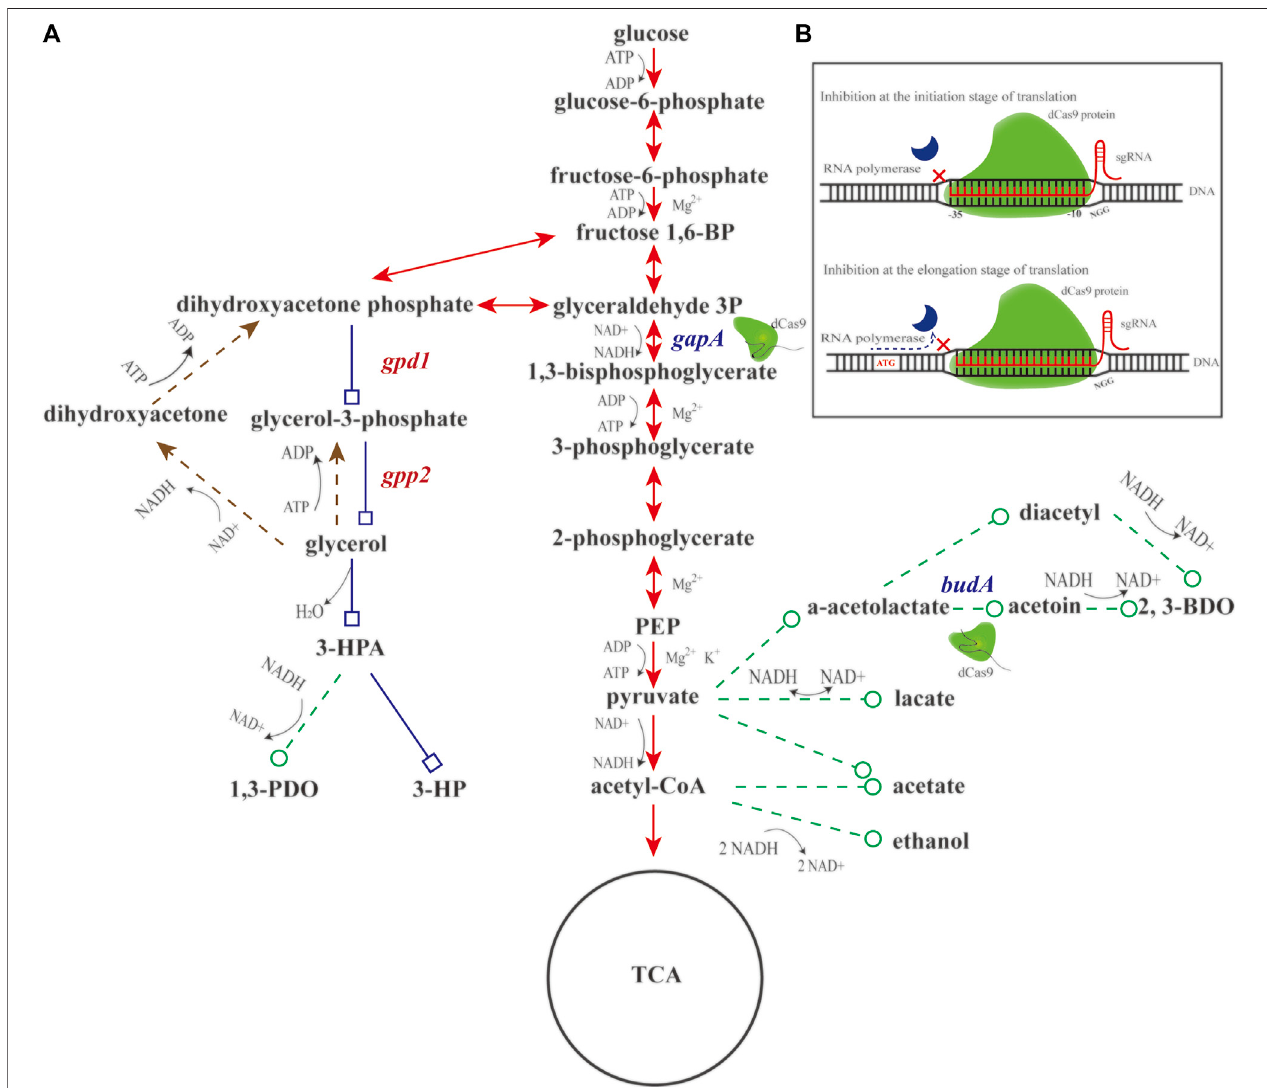
FIGURE 1 | Schematic diagram of engineering glucose-to-glycerol pathway and CRISPRi system in K. pneumoniae . (A) Diagram of engineering glucose-to- glycerol pathway. (B) Diagram of the CRISPRi system. Triangular arrow of solid line denotes the EMP pathway. Triangular arrow of dotted line denotes the glycerol oxidation pathway. Square arrow of solid line denotes the engineered glucose to 3-hydroxypropionic acid (3-HP) pathway, and circular arrow of dotted line denotes by- product pathways. gapA and budA are two native genes inhibited by CRISPRi. gpd1 and gpp2 are two heterologous genes introduced for glycerol production. Fructose 1,6-BP, fructose 1,6-diphosphate; glyceraldehyde 3P, glyceraldehyde-3-phosphate; PEP, phosphoenolpyruvate; 3-HPA, 3-hydroxypropionaldehyde; 3-HP, 3-hydroxypropionic acid; 1,3-PDO, 1,3-propanediol; 2,3-BDO, 2,3-butanediol; gpd1 , glycerol 3-phosphate dehydrogenase; gpp2 , glycerol 3-phosphatase; gapA , glyceraldehyde-3-phosphate dehydrogenase; and budA , α -acetolactate decarboxylase.